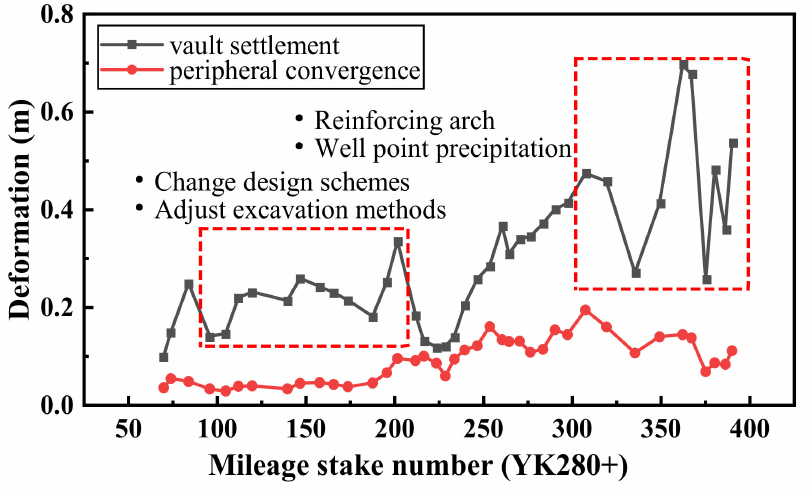
Figure 5. Deformation curves and control measures for the part of the mileage of the right line of the